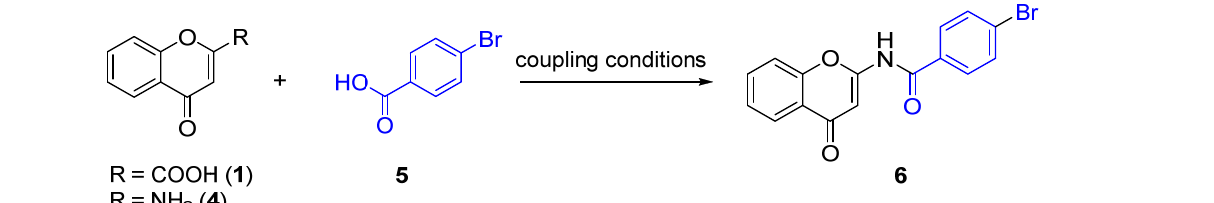
Table 1. Optimization of the coupling conditions for obtaining of chromone carboxamide 6 .